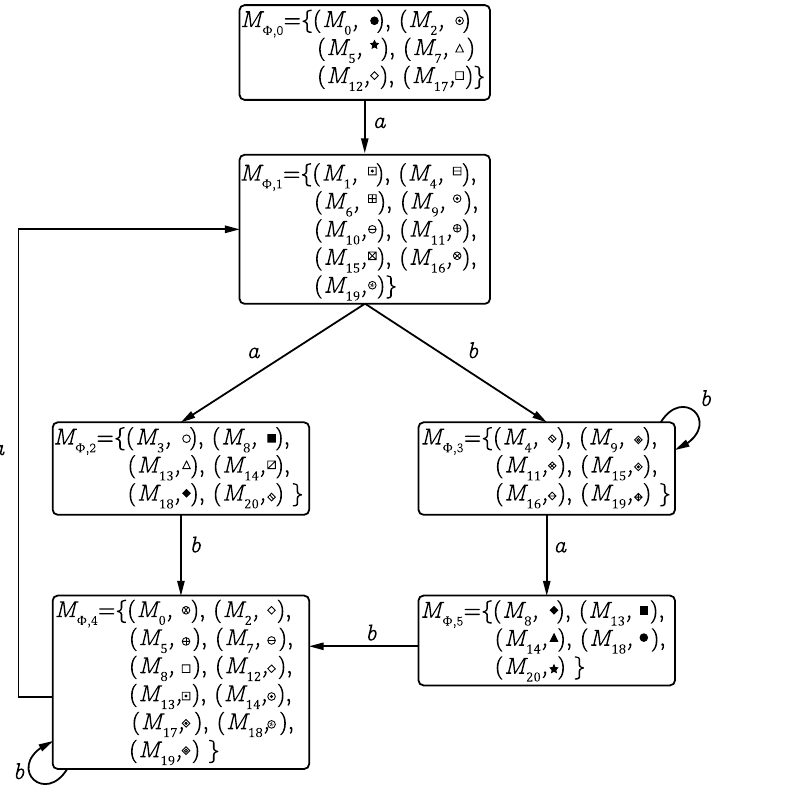
Figure 10. The colored estimator of the observer